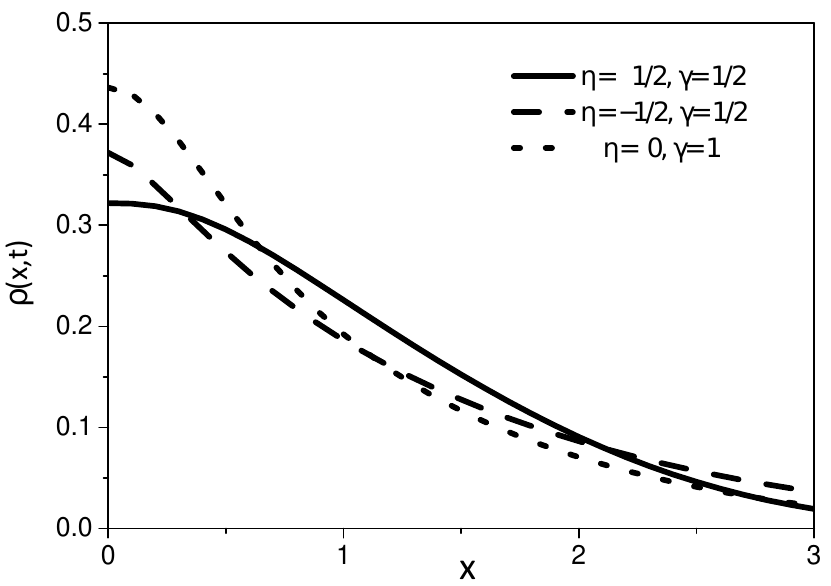
Figure 7. This figure shows the behavior of the Equation (27) for different values of η and γ , with κ ( t ) = ( κ / τ (cid:48) ) e − t / τ (cid:48) . We consider, for simplicity, ¯ κ = 1, τ (cid:48) = τ , x (cid:48) = 1/2, and D τ =